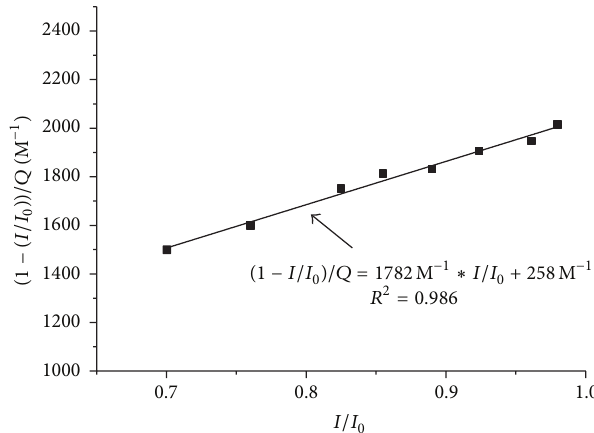
Figure 7: Plot of ( 1 − (𝐼/𝐼 0 ))/𝑄 against 𝐼/𝐼 0 at different concentrations of 1